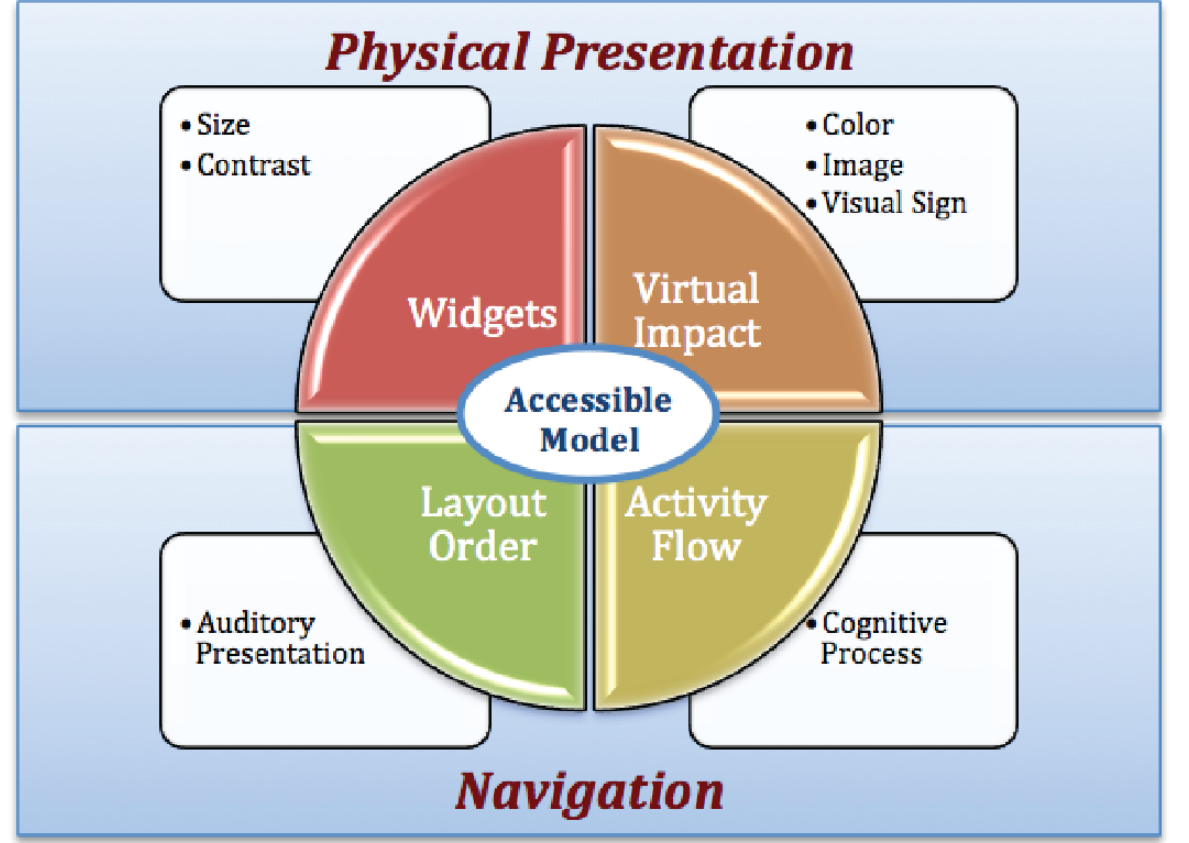
Figure 2. Four elements of the user